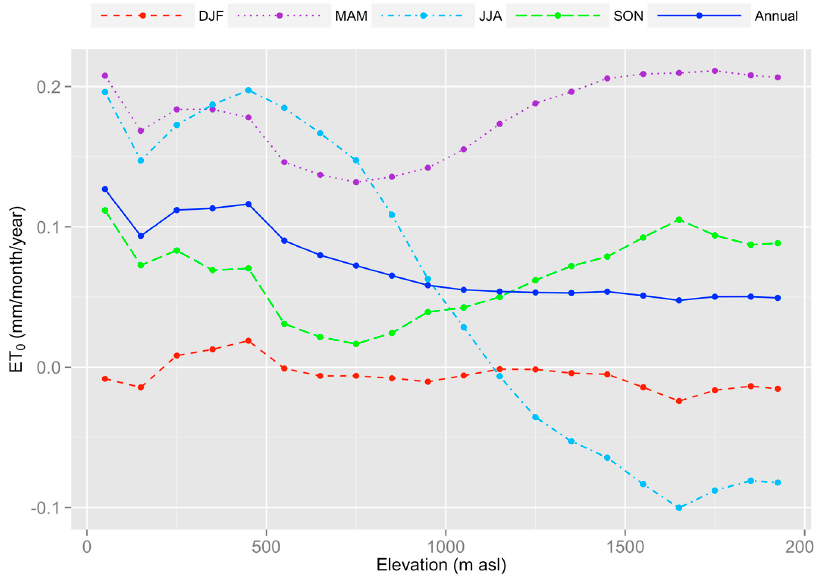
Figure 10. Elevational variation in the annual change in monthly ET 0 . The solid blue line represents the annual average; the seasonal averages for DJF, MAM, JJA, and SON are presented using dashed red, dotted purple, dashed-dotted light blue, and dashed green lines, respectively.